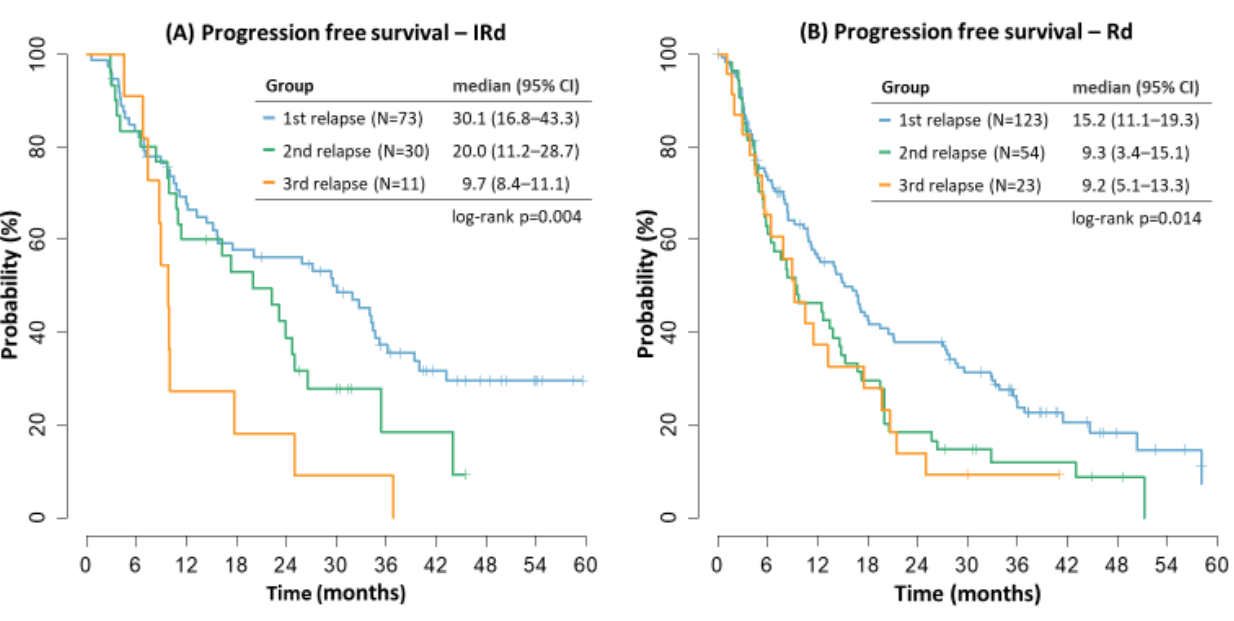
Figure 2. Progression free survival by treatment line.